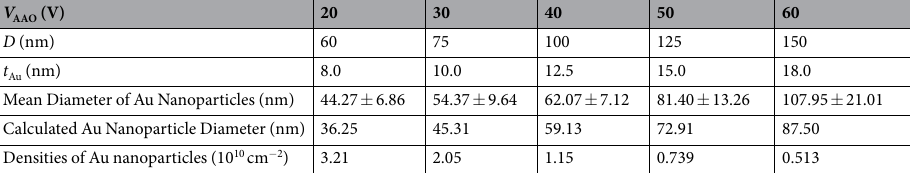
Table 1. Experimental and calculated results for realizing ‘one particle per bowl’